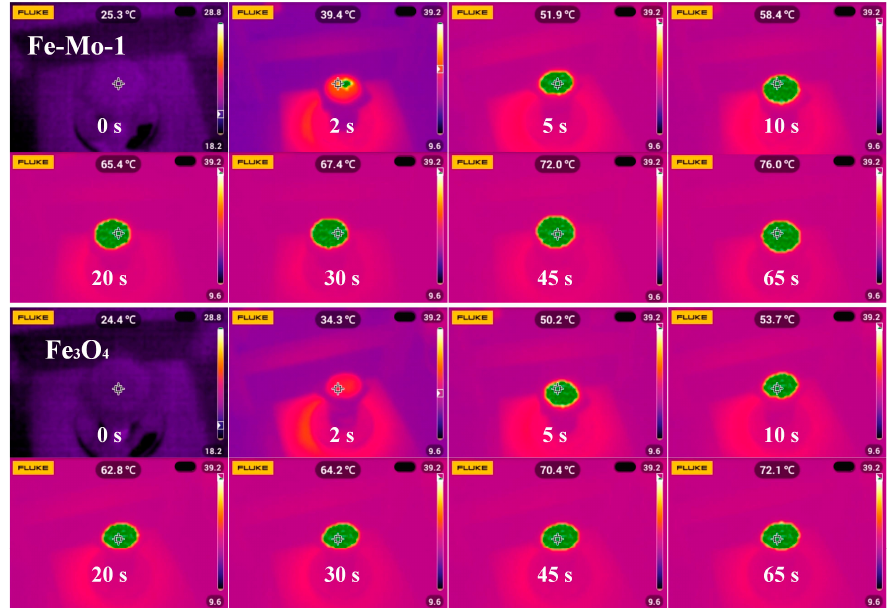
Figure 6. Infrared radiation images of Fe-Mo-1 (dried) and Fe 3 O 4 (dried) at different times during the experiment.